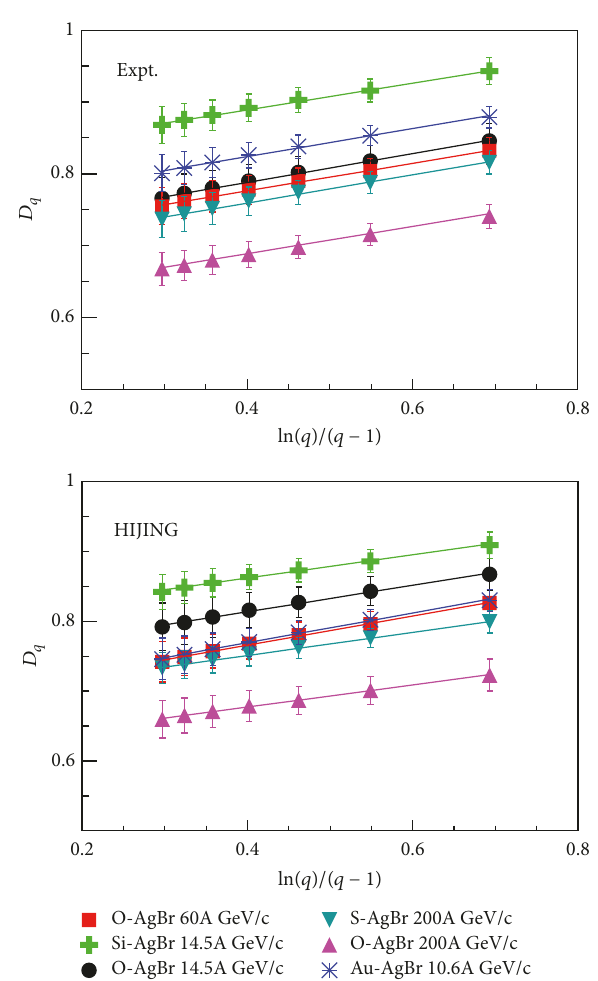
Figure 5: 𝐷 𝑞 versus ln (𝑞)/(𝑞 − 1) plots for the experimental and HIJING data at various